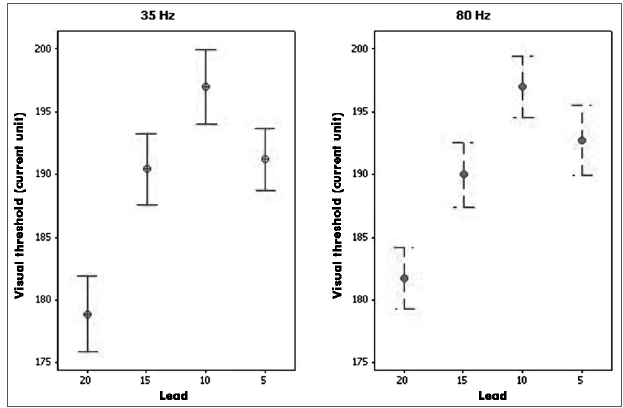
Figure 2. Visual Neural Response Thresholds - Results of means ± standard errors of the visual neural response threshold in electrodes 20, 15, 10, and 5, at 35 and 80 Hz stimulation frequencies.